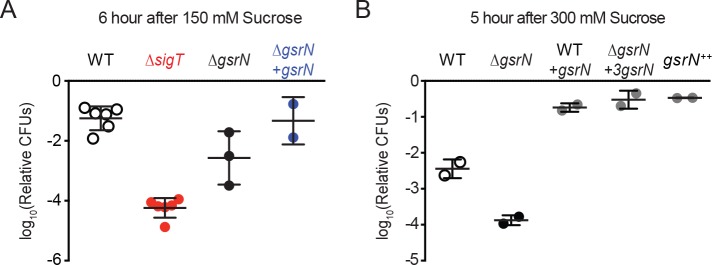
GsrN is required for osmotic stress survival.(A) Relative CFUs of wild type, ΔsigT, ΔgsrN, and complementation strain (ΔgsrN +gsrN) treated with 150 mM sucrose for 6 hr. These conditions parallel previous osmotic stress studies (Alvarez-Martinez et al., 2007) and are used to characterize stress sensitive genotypes. Data are normalized as in Figure 2A. Data represent mean ±SD from at least two biolgical replicates (points). (B) Relative CFUs of wild type, ΔgsrN, and overexpression strains of gsrN treated with 300 mM sucrose for 5 hr. These conditions are used to characterize stress protective genotypes. Data represent mean ±SD from two independent experiments (points).